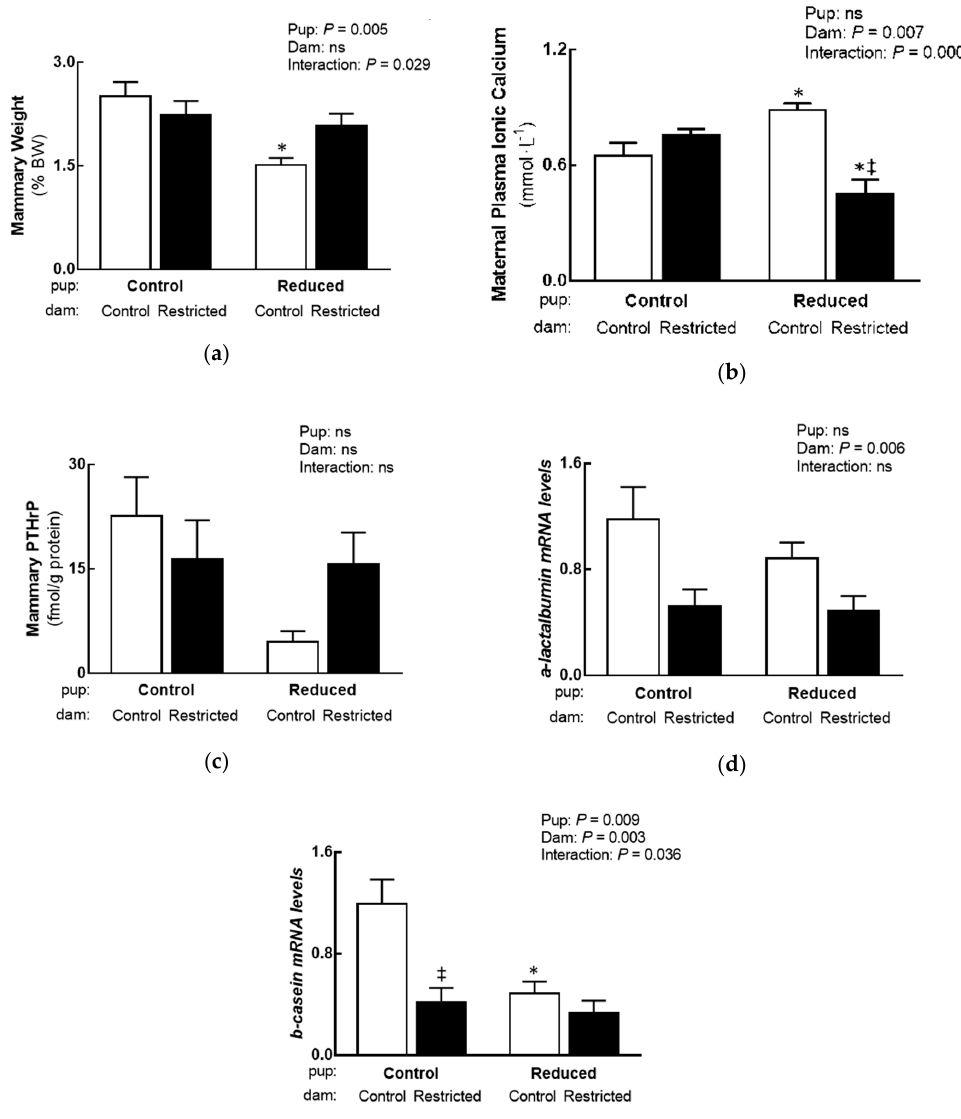
Figure 2. Effect reducing litter size has on maternal and mammary outcomes ( n = 5–9 per group). ( a ) Mammary weight, ( b ) maternal ionic calcium concentrations and ( c ) mammary PTHrP protein